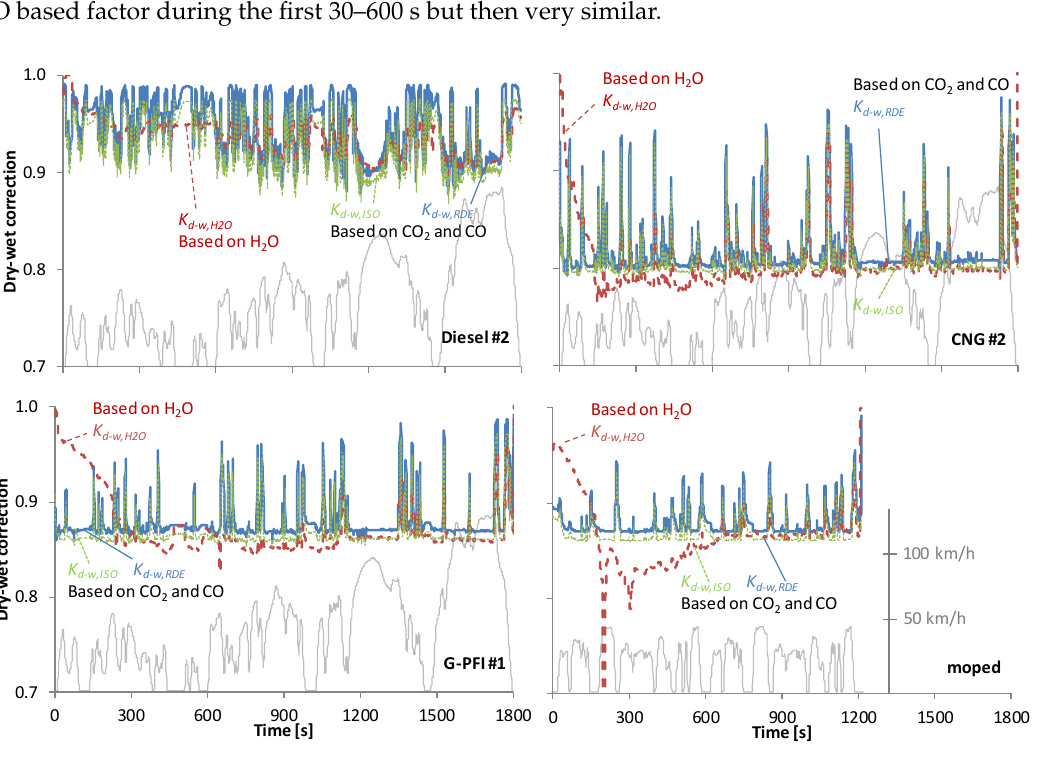
Figure 2. Dry-wet correction factor from dry-based carbon dioxide (CO 2 ) and carbon monoxide (CO) laboratory measurements (non-dispersive infrared detection (NDIR)) or H 2 O measurements from Fourier-transform infrared spectroscopy (FTIR) during cold start cycles for some vehicles. The grey lines are the speed profiles of the WLTC (light-duty vehicles) and WMTC (L-category) (right-hand scale).